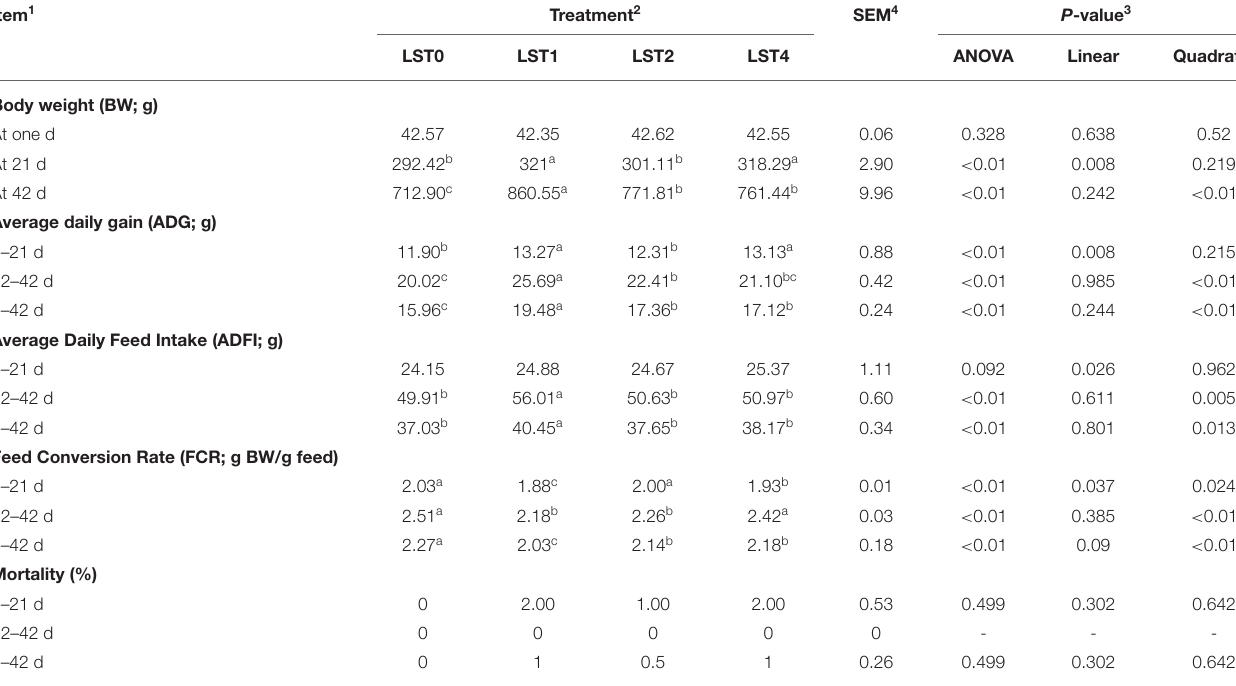
TABLE 3 | Effect of dietary LST powder supplementation on growth performance of broiler chickens. Item 1